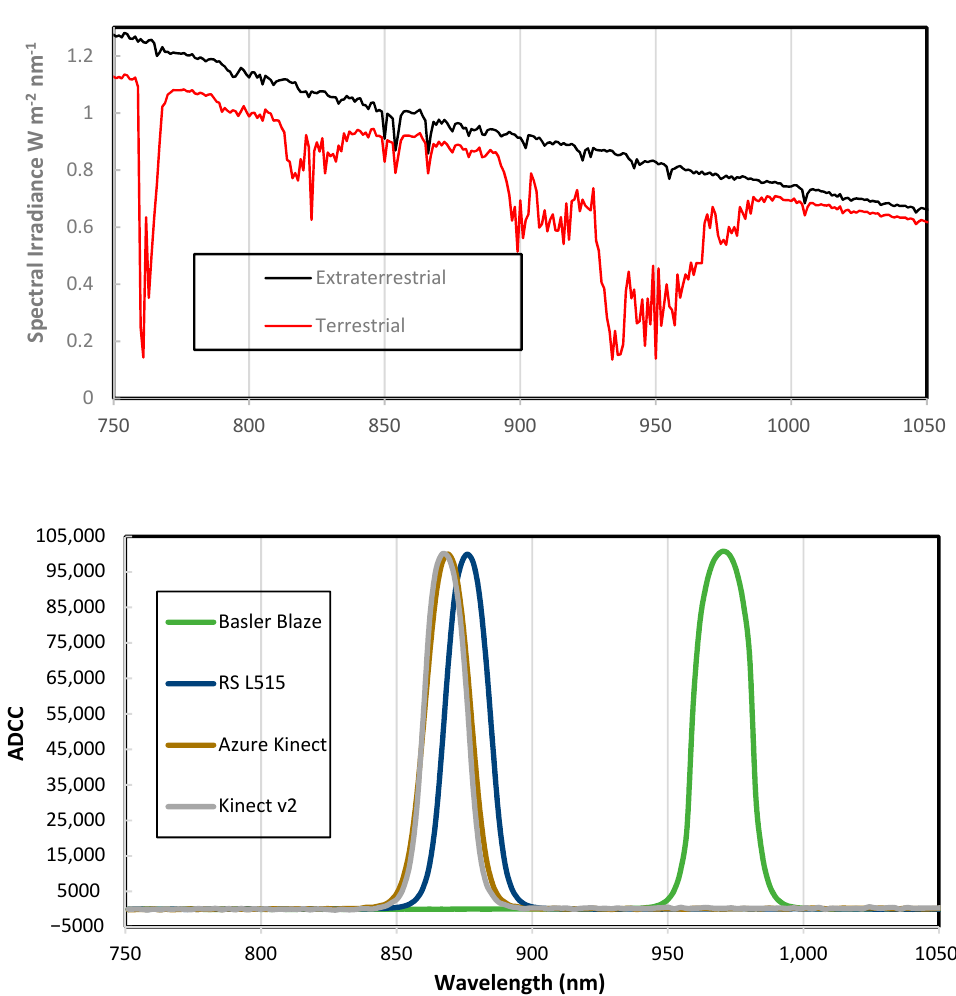
Figure 4. Top panel : Reference solar spectral irradiance: extraterrestrial and terrestrial ([33] with permission). Bottom panel : Analogue to Digital Conversion Count (ADCC) output of spectrometer for light emitted by four depth cameras and for sunlight. Y -axis values are normalized to a peak of 100,000